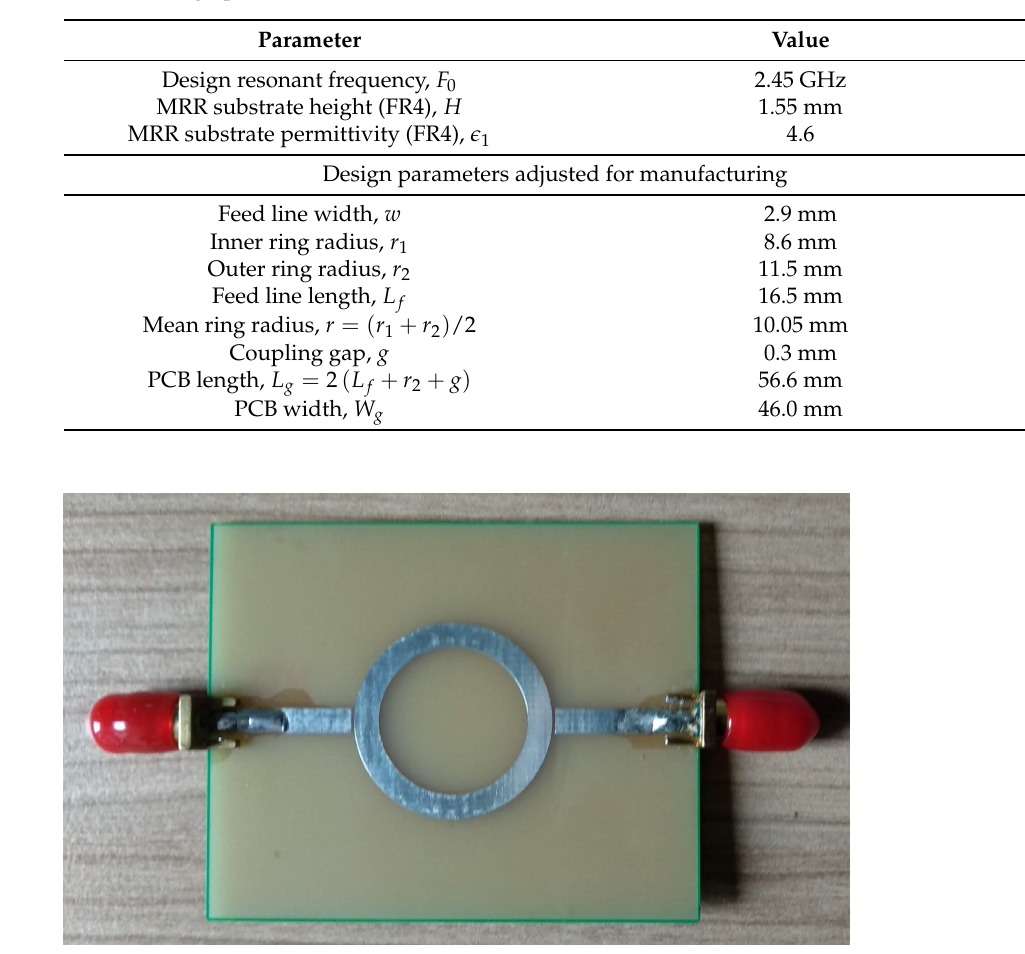
Table 1. Design parameters of our MRR.